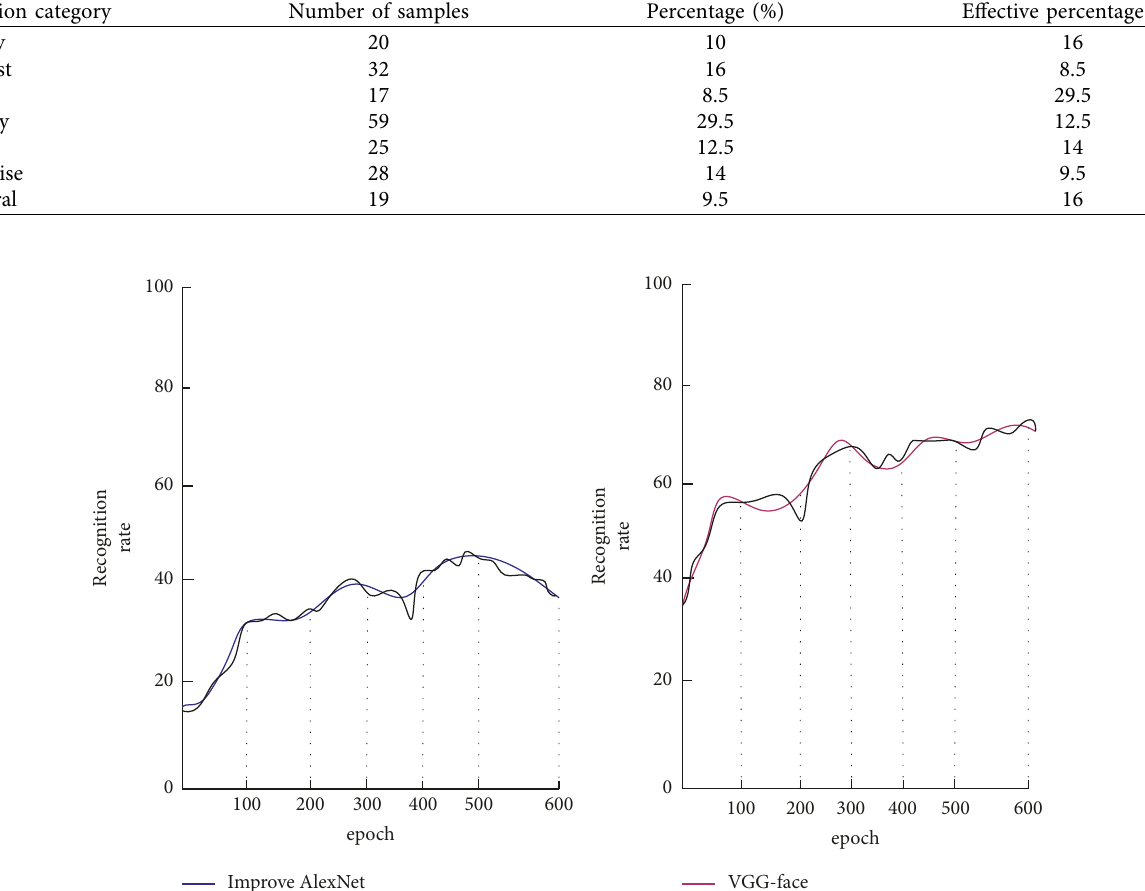
Table 3: Basic emotional situation of 200 students.